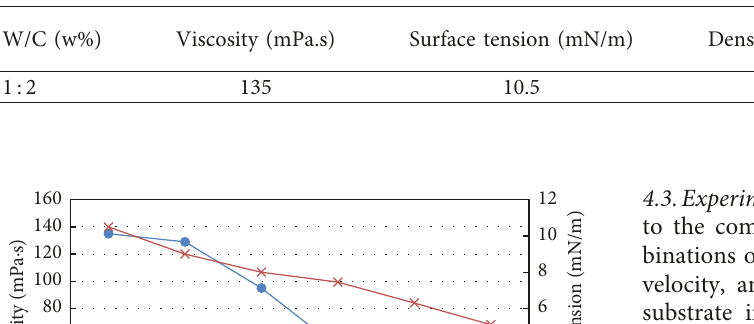
Figure 7: Experimental substrate morphology measurement and reconstruction. (a) Substrate topography measurement. (b) Substrate roughness measurement. (c) Substrate topography reconstruction results. Table 4: Basic properties of the grout used.